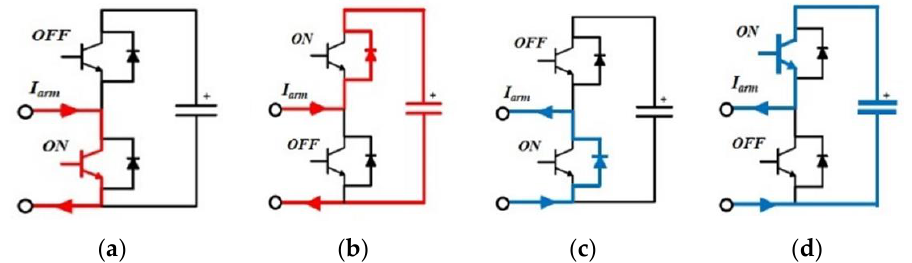
Figure 7. Current flow in the sub-module according to switching state: ( a ) Bypass in positive polarity ( b ) Charging in positive polarity ( c ) Bypass in negative polarity ( d ) Discharging in negative polarity. Table 1. Switching state of the Sub-Module conditions.